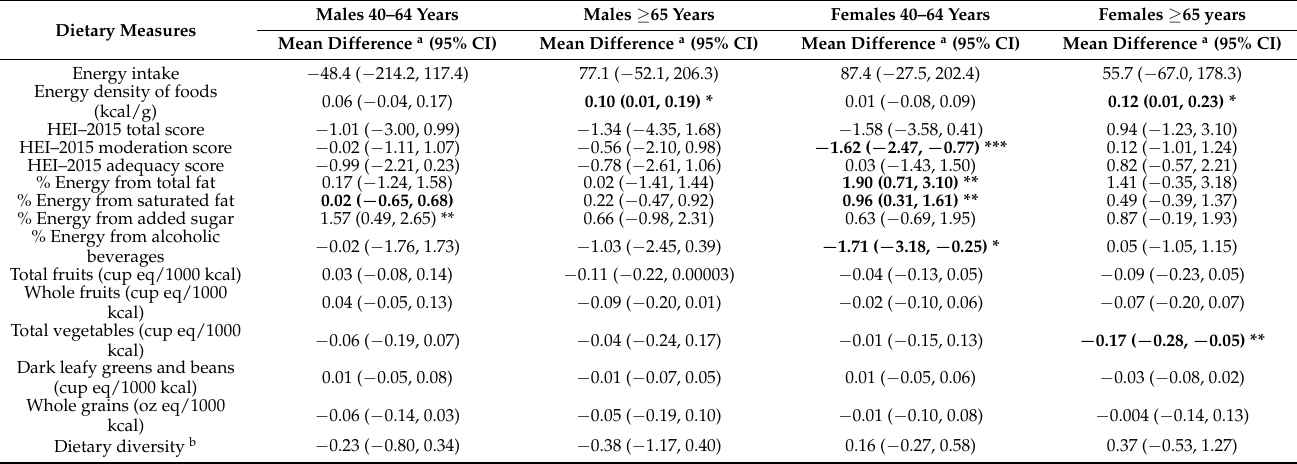
Table 4. Associations between self-reported olfactory function and dietary attributes by age and sex among NHANES 2011–2014 participants, ages 40 years and older, tested in survey-weighted regression